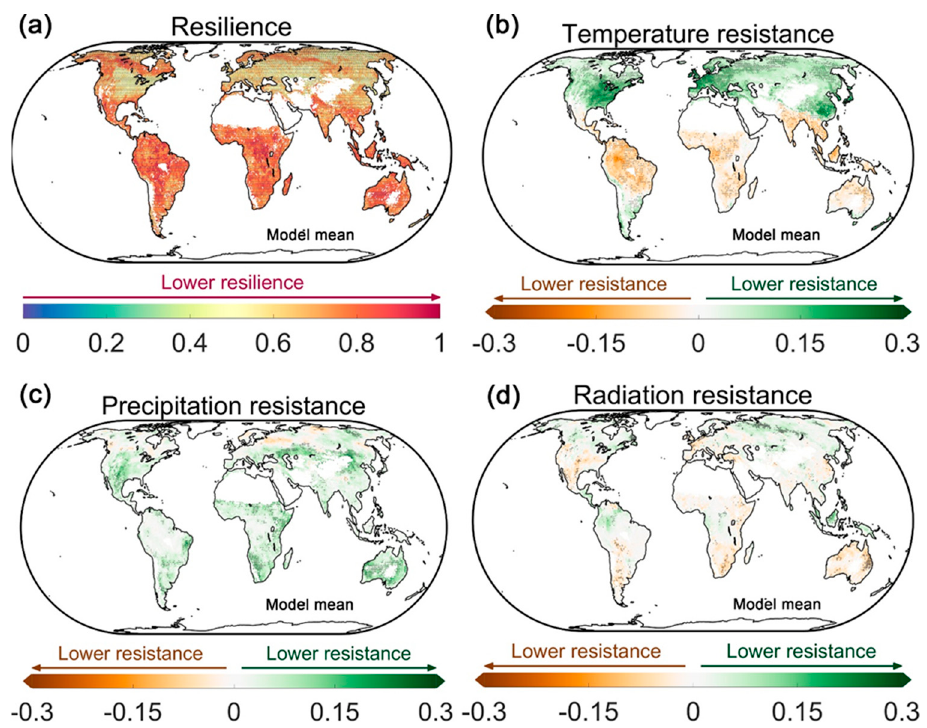
Figure 3. Spatial patterns of averaged vegetation resilience and resistance to climatic variables by six DGVMs: ( a ) vegetation resilience; ( b ) temperature resistance; ( c ) precipitation resistance; ( d ) radiation resistance. If the vegetation resilience or climate resistance are significant ( p < 0.05) in more than 3 models in a pixel, averaged vegetation resilience and resistance to climatic variables by six DGVMs are significant in that pixel. In each subfigure, stippling indicates that the vegetation resilience or climatic resistance is significant ( p < 0.05). Vegetation resilience is within the range of 0 and 1, and larger values suggest lower resilience. Climatic resistance is within the range of − 1 and 1, and values with larger absolute magnitudes indicate lower climatic resistance.